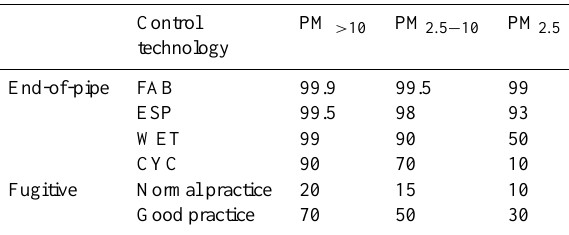
Table 5. Removal efficiency of different PM control technologies, numbers show as